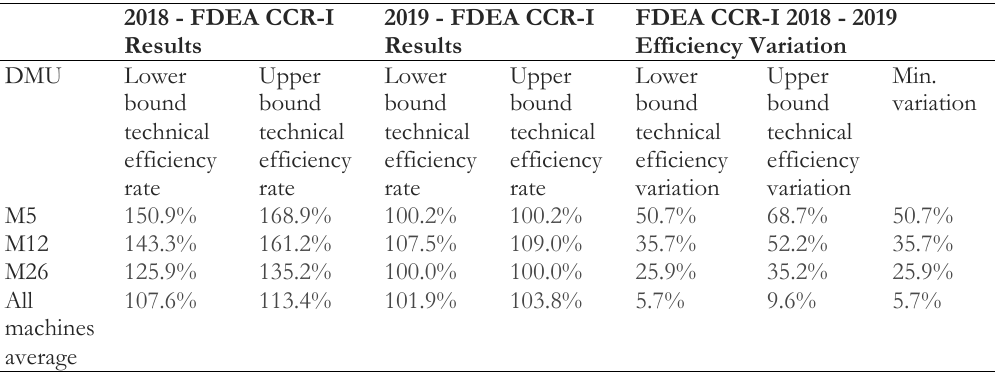
Table 7. CCR – input oriented classical DEA results and efficiency variations.